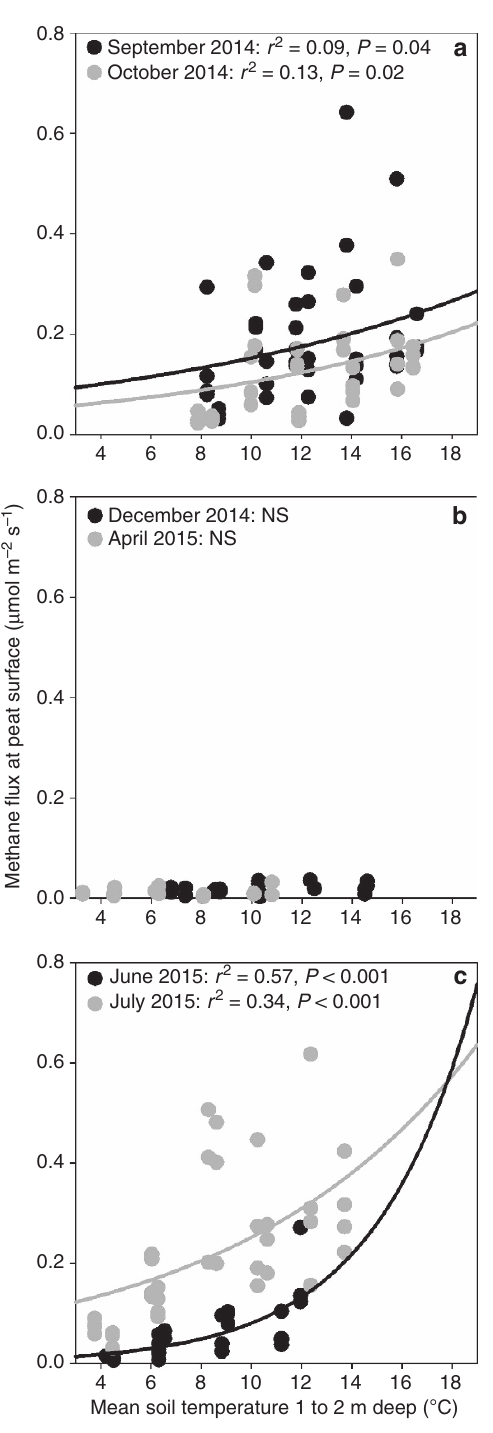
Figure 3 | Seasonal CH 4 fluxes from S1 bog. Seasonal CH 4 flux vs in situ temperatures from 1.2m diameter collars during ( a ) fall 2014, ( b ) winter 2014-2015 and ( c ) summer 2015. Black and grey dots distinguish between daily averages for two different sampling times during each season. Significant correlations between flux and temperature as exponential regressions are indicated on the graphs by black lines for September ( a ) and June ( c ), and grey lines for October ( a ) and July ( c ).